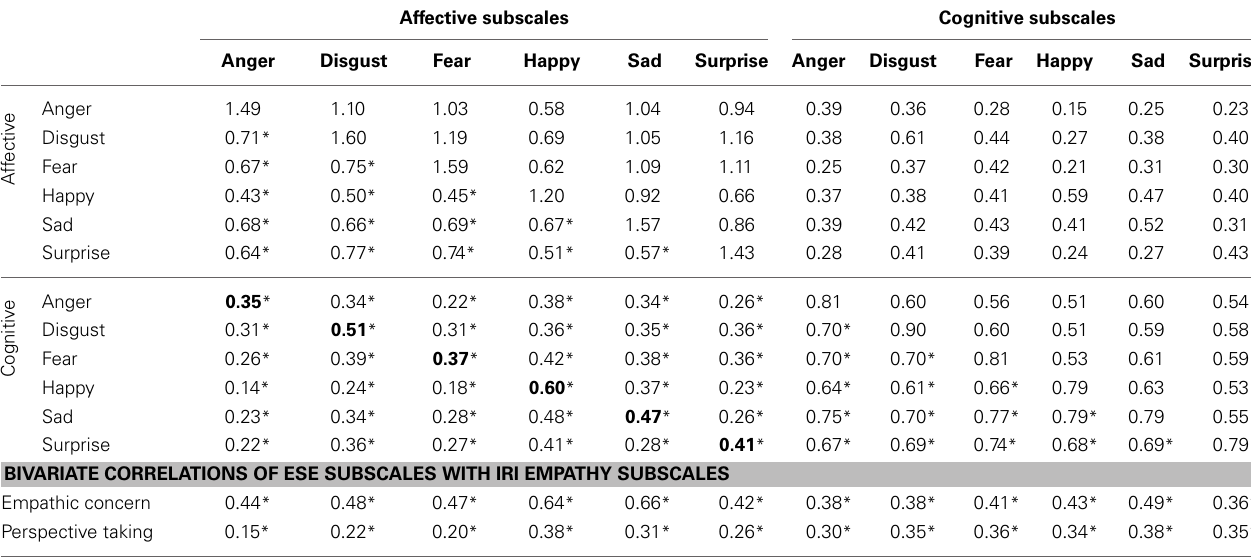
Table 3 | ESE subscale correlations and covariances. Affective subscales Cognitive subscales